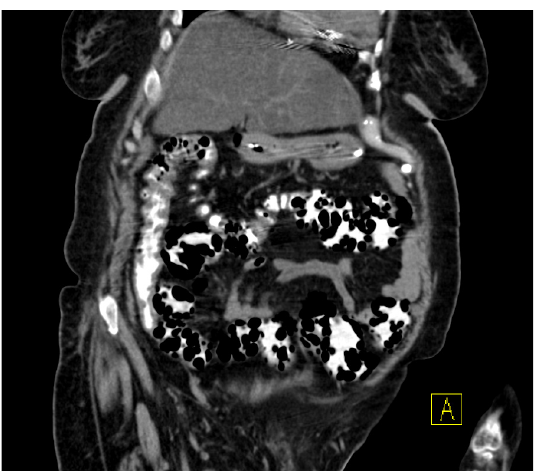
Figure 3. In computerized tomography, air-filled cysts in both submucosal and subserosal layers of the colonic